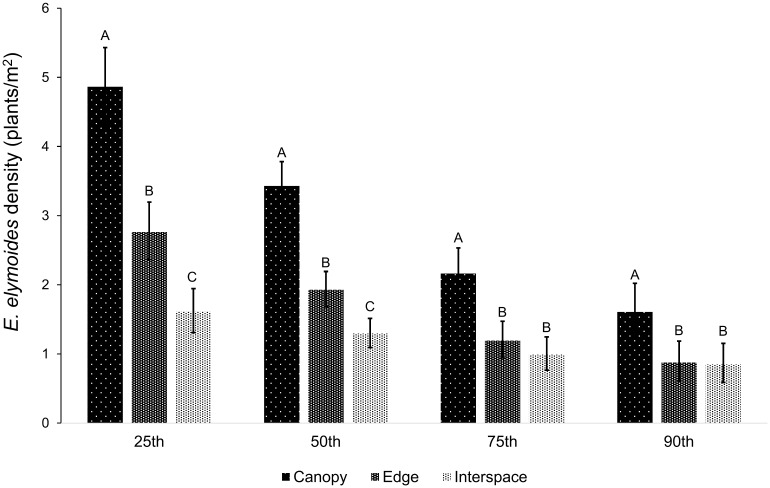
Least square means for E. elymoides density (plants/m2) at 25th, 50th, 75th, and 90th percentile values of rainfall.Error bars represent standard error of the mean; different letters denote means that differ significantly from one another within each percentile of rainfall.